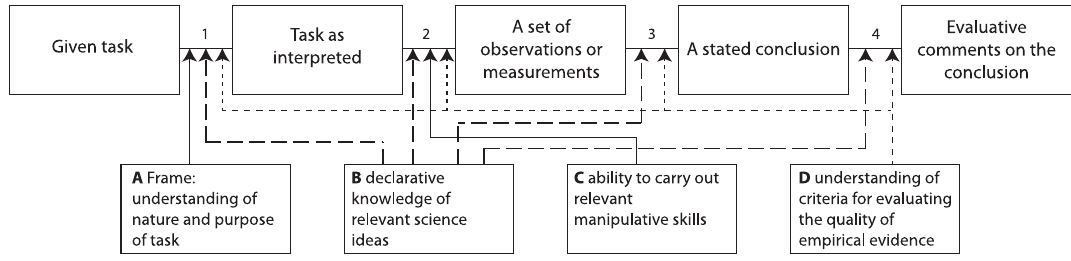
FIG. 1. In their PACKS model, Millar et al. [18] link how the taking of decisions during various stages of an inquiry is informed by different types of